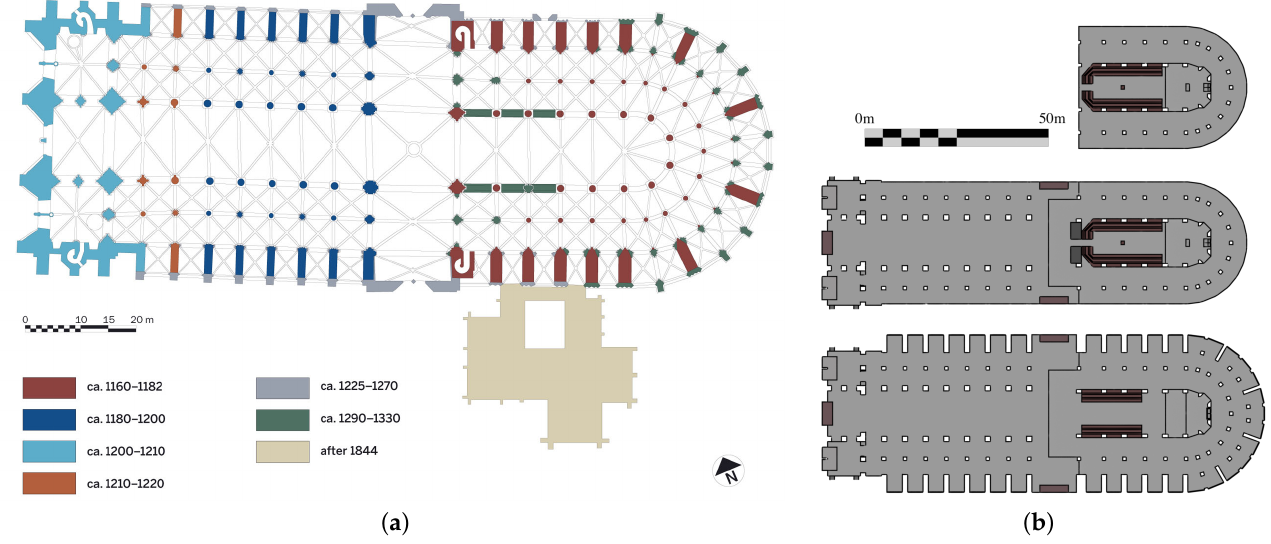
Figure 1. Floor plans of Notre-Dame de Paris: ( a ) with principal phases of construction, from [47]; ( b ) after the main campaigns, from [49]. From top to bottom: ca. 1182, ca. 1230, ca.